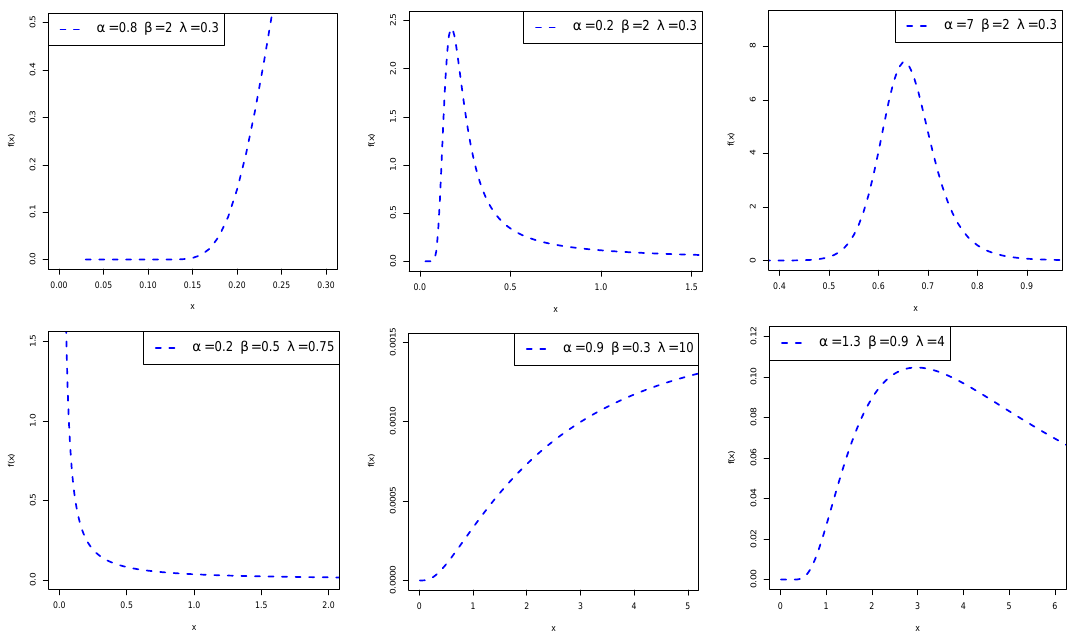
Figure 1. Plots of the inverse power logistic exponential (IPLE) PDF for different parametric